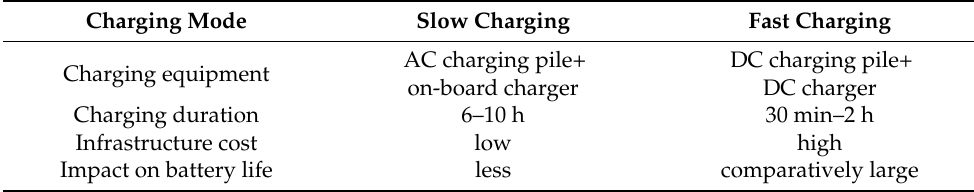
Table 1. EV charging mode